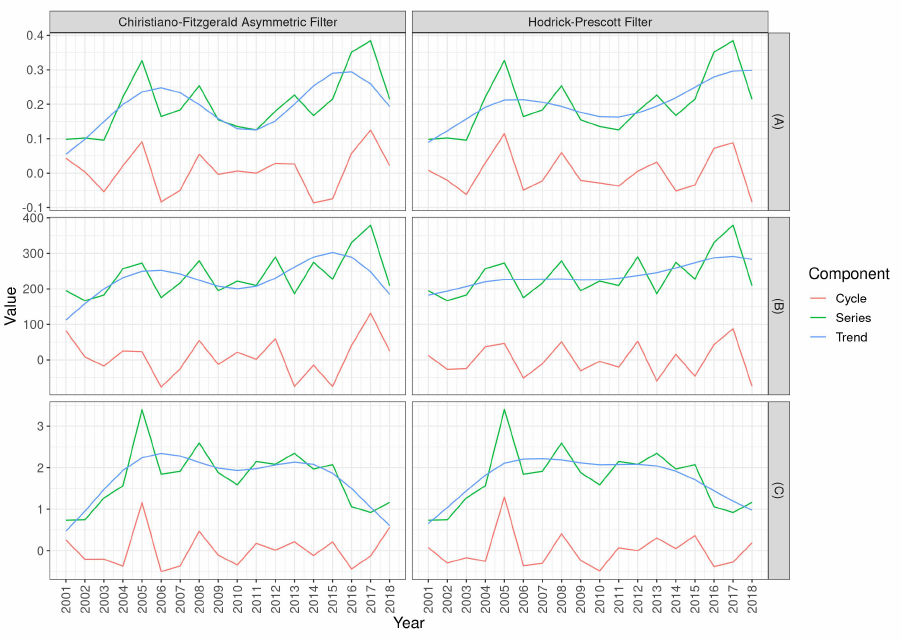
Figure S7 – Time series decomposition of yearly averages per 100 km 2 of (A) Forest loss area (in km 2 ) of large clearings (>1 ha in size); (B) Number of small clearings (<1 ha in size); (C) Number of fire points remotely sensed by the MODIS sensor in or around forest loss